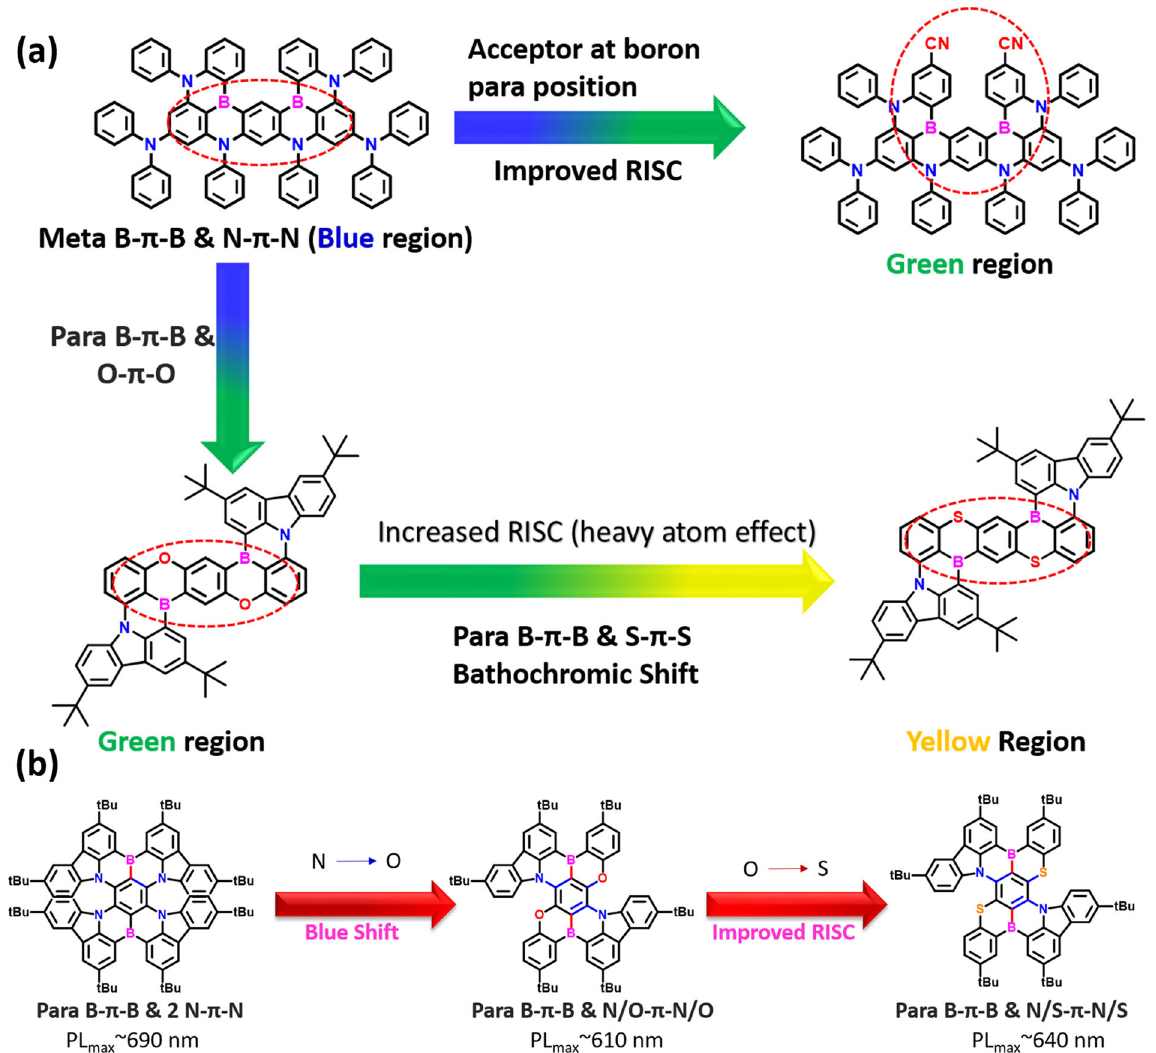
Fig. 4 Pure green to red color DB-MR-TADF strategies. Design approach for developing ef fi cient ( a ) green to ( b ) red color DB-MR-TADF